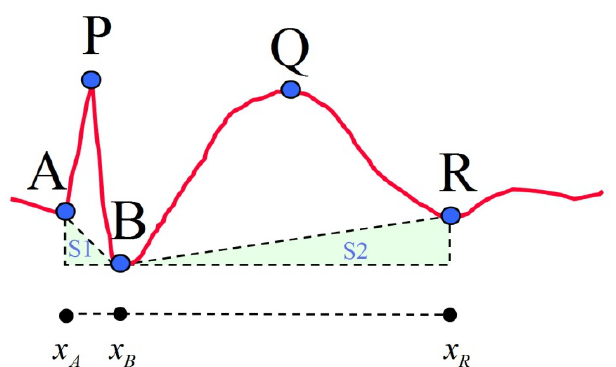
Figure 3. Reference diagram for feature extraction.